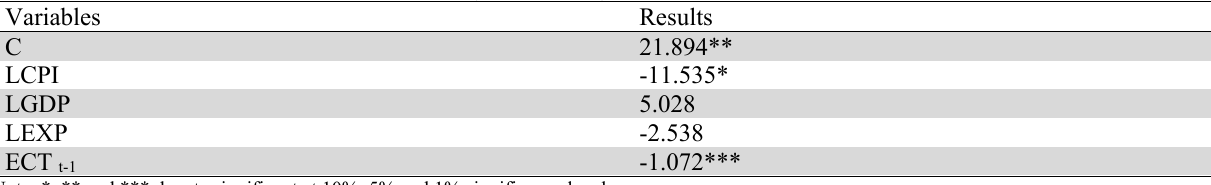
The Estimated Short-run Error Correction term (ECT-ARDL) results